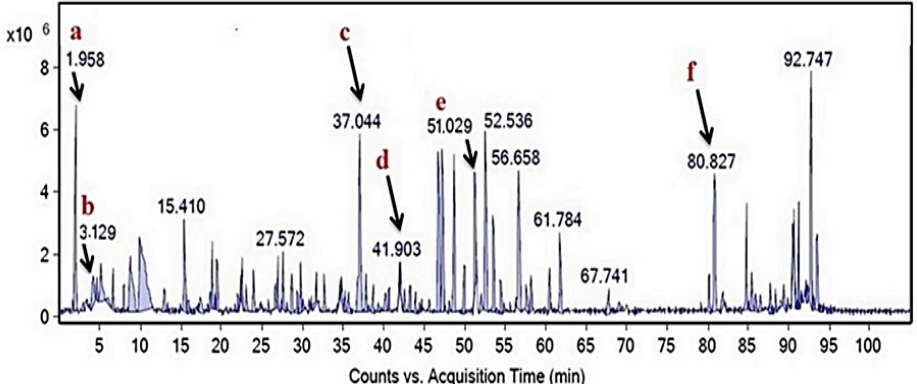
Figure 6. LC-QTOF MS chromatogram of M. oleifera ethanol extract. The identified compounds shown are: ( a ) lactobionic acid; ( b ) L -ascorbic acid-2-glucoside; ( c ) luteolin 7-(6 ′′′ -acetyl allosyl-(1->2)-glucoside); ( d ) luteolin 7-methyl glucuronide; ( e ) 3-hydroxylidocaine glucuronide; ( f ) luteolin.